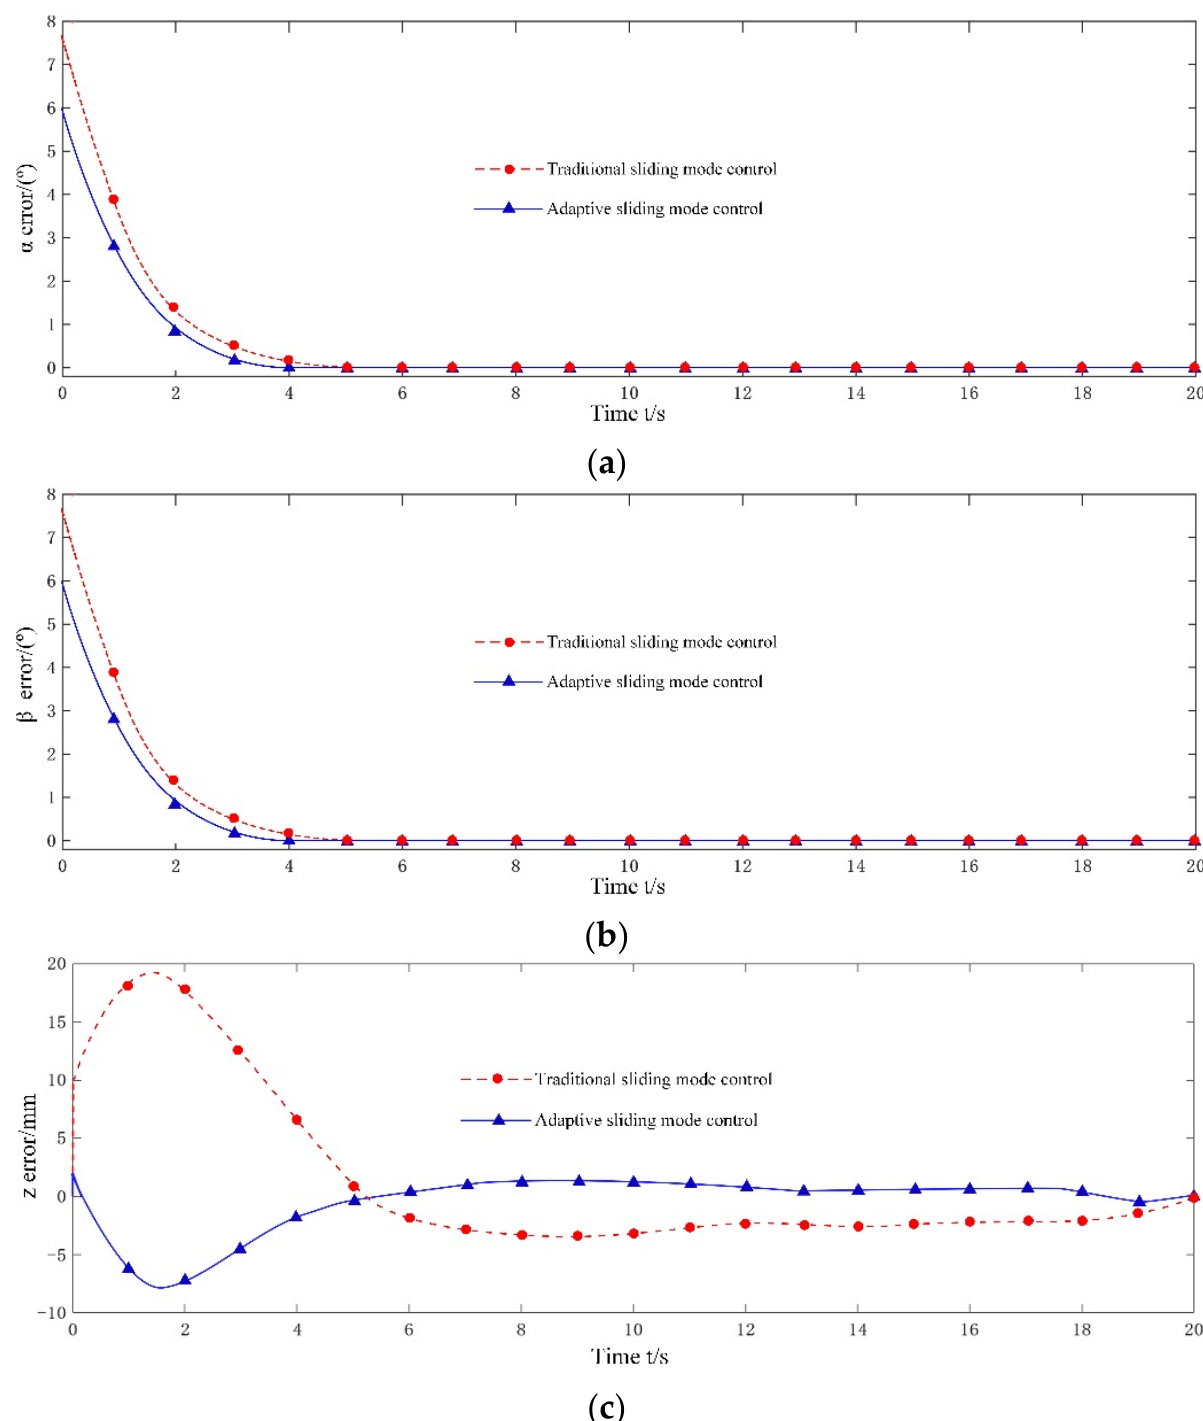
Figure 8. The pose tracking error of the moving platform in the simulation experiment. ( a ) α position and attitude tracking error of moving platform; ( b ) β position and attitude tracking error of moving platform; ( c ) z position and attitude tracking error of moving platform. Theoretical calculations and simulation experiments had a certain guiding